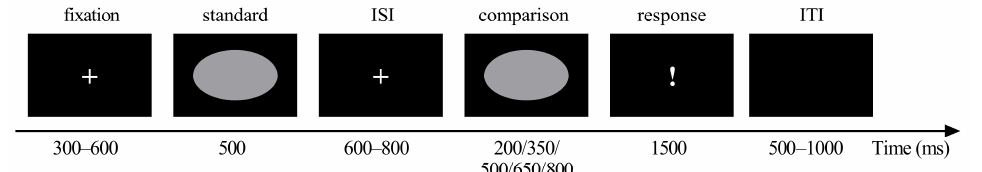
Figure 1. A depiction of the sub-second temporal discrimination task in Experiment 1. ISI: inter- stimulus interval. ITI: inter-trial interval.